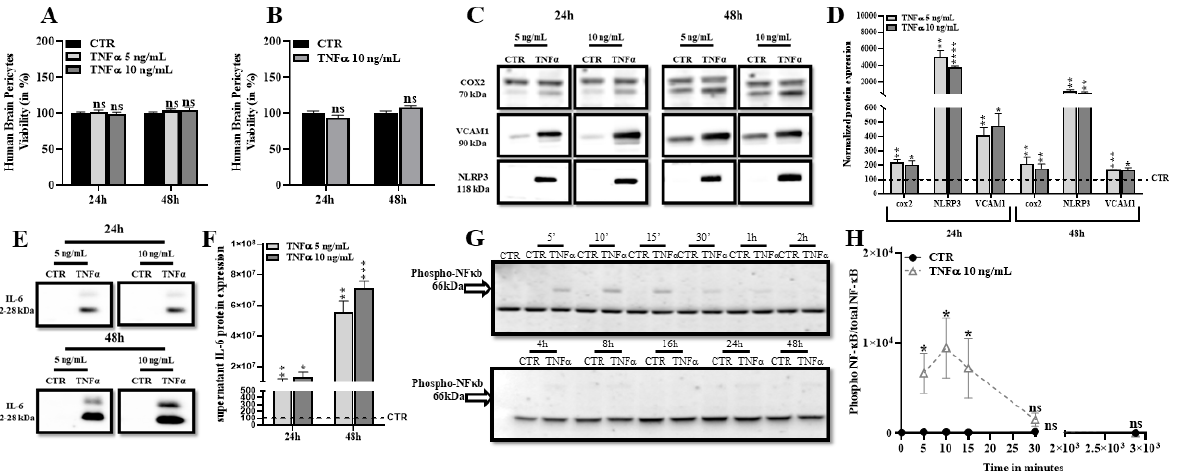
Figure 1. TNFα induces inflammatory markers expression but does not affect HBP viability. ( A ). After TNFα treatment, HBP were incubated with resazurin. Viable HBP converted resazurin into fluorescent Resorufin, which was measured and represented in percentage relative to the control condition (CTR). Each bar represents the mean ± SEM of three independent experiments with four replicates each (N = 3; n = 12) . Statistical analysis: Student’s t -test, ns: non-significant. ( B ). MTT assay was performed to the highest applied dose. Data are shown as the mean ± SEM of three experiments with eight replicates each (N = 3, n = 24) . Statistical analysis: Student’s t -test, ns: non-significant. ( C ). Cell inflammatory markers ’ ( COX2 , NLRP3 , VCAM1 ) protein levels were monitored by Western blot. ( D ). Each bar represents the level of quantified protein signal normalized to ACTIN relative to the CTR. Data are shown as the mean ± SEM of three independent experiments (N = 3). ( E ). Secreted inflammatory marker IL-6 protein level was analyzed by Western blot after supernatant proteins precipitation. ( F ). Each bar represents the level of quantified protein signal normalized to albumin relative to the CTR. Statistical analysis: Student’s t -test, * p < 0.05, ** p < 0.01, *** p < 0.001, **** p < 0.0001. ( G ) . TNFα treatment was performed in kinetic and NF - κB pathway activation was analyzed by Western blot. ( H ). Data are shown as the mean ± SEM of three independent experiments (N = 3). Statistical analysis: Studen t’s t -test, ns: non-significant, * p < 0.05.